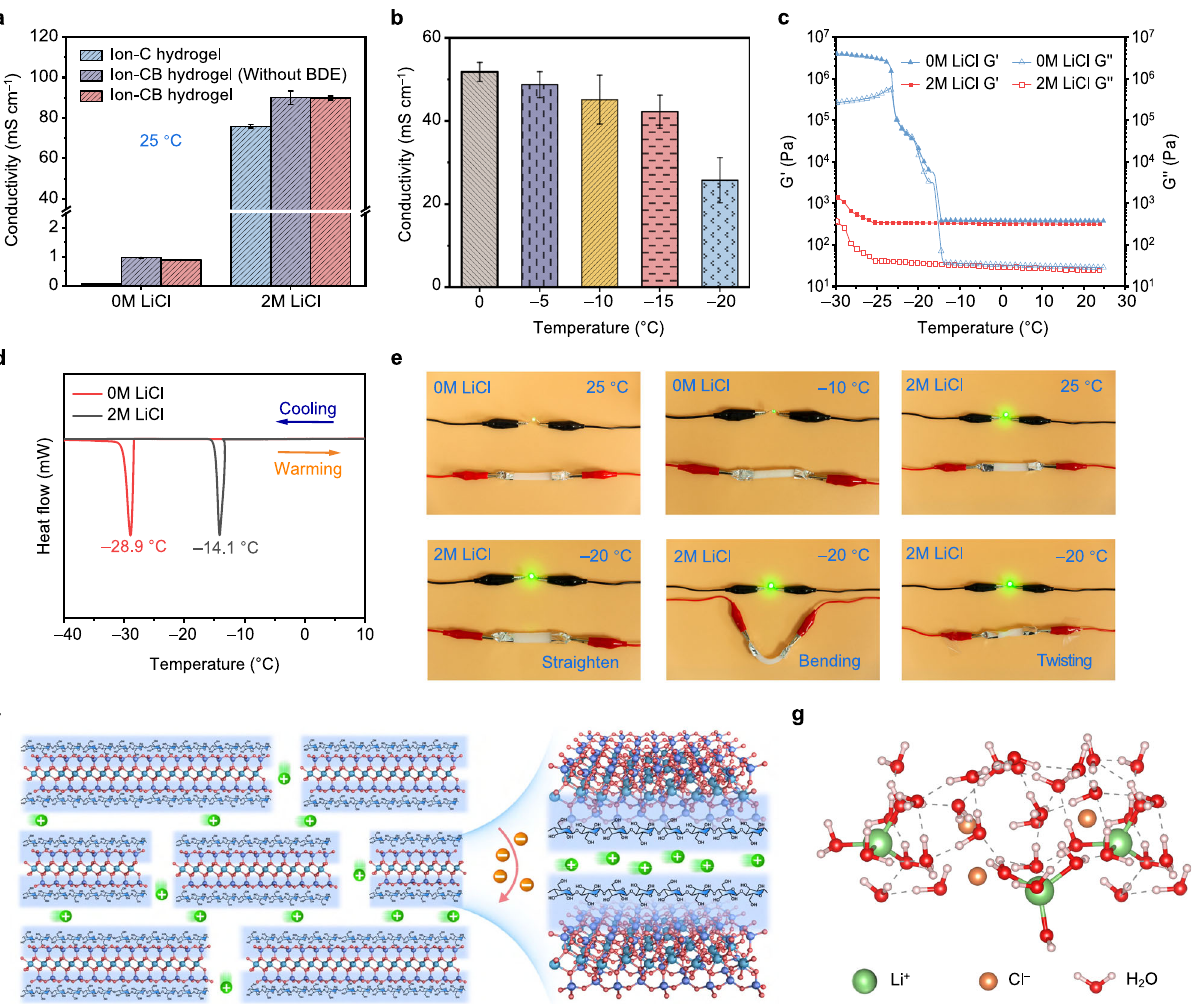
Fig. 5 Study of the mechanism of high ionic conductivity and anti-freezing property. a Ionic conductivity of hydrogels at 25 °C. b Ionic conductivity of Ion-CB hydrogels with varying temperatures. c , d Storage moduli (G ’ ) and loss moduli (G ” ) ( c ) and DSC curves ( d ) of cellulose/BT hydrogel and Ion-CB hydrogel. e Comparisons of luminance of LEDs (working voltage of 3.0 V) using cellulose/BT hydrogel and Ion-CB hydrogel as the conductor in the fl at, bending, and twisting state at varying temperatures. f The ions move on the layered BT nanoplatelets with cellulose fi bers. g Schematic diagram for freezing tolerance mechanism of the hydrogel. Data in ( a , b ) are presented as mean values ± SD, n = 3 independent measurement result shown in Fig. 5d, where the peaks located at − 14.1 and − 28.9 °C correspond to the freezing point of the cellulose/BT hydrogel and the Ion-CB hydrogel, respectively.